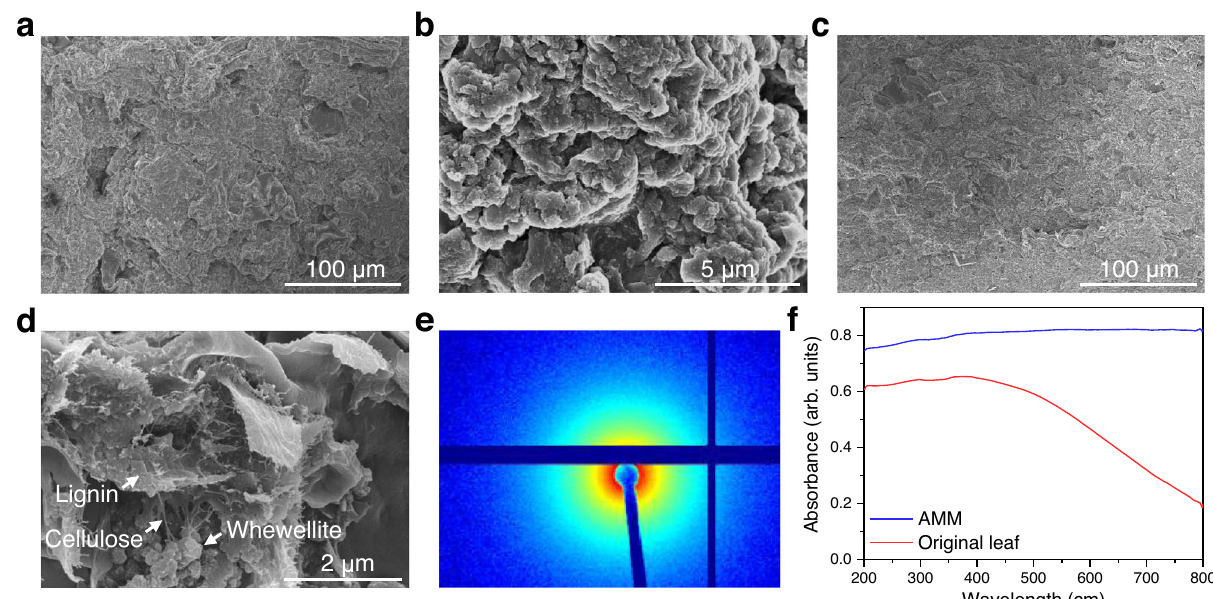
Fig. 3 | Morphology, structure,and light absorptionofthe AMM fi lm. a , b Top- viewSEMimagesoftheAMM fi lm. c , d Cross-sectionalSEMimagesoftheAMM fi lm